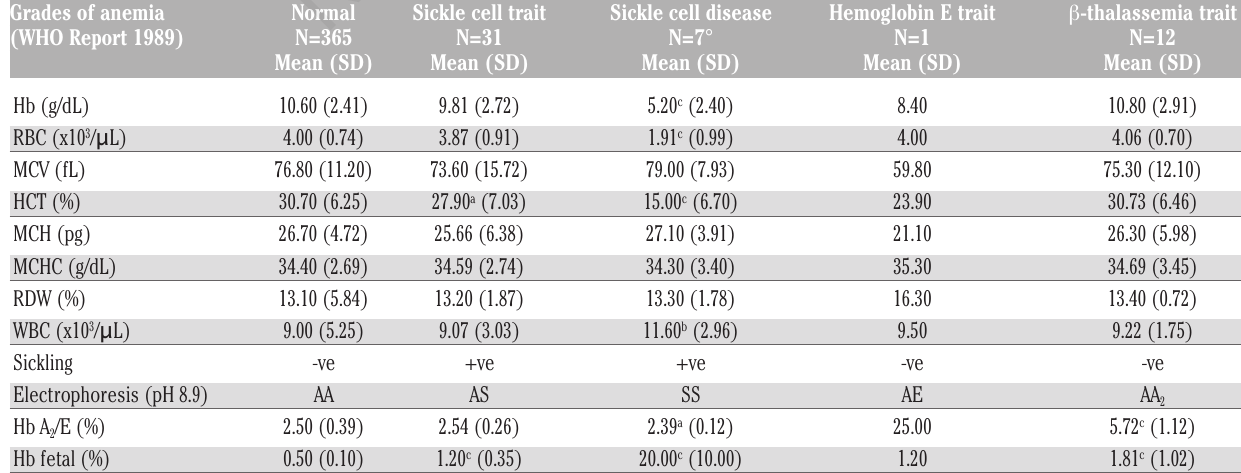
Table 3. Comparison of hematological indices of pregnant women with and without (Normal) hemoglobinopathies. Grades of anemia